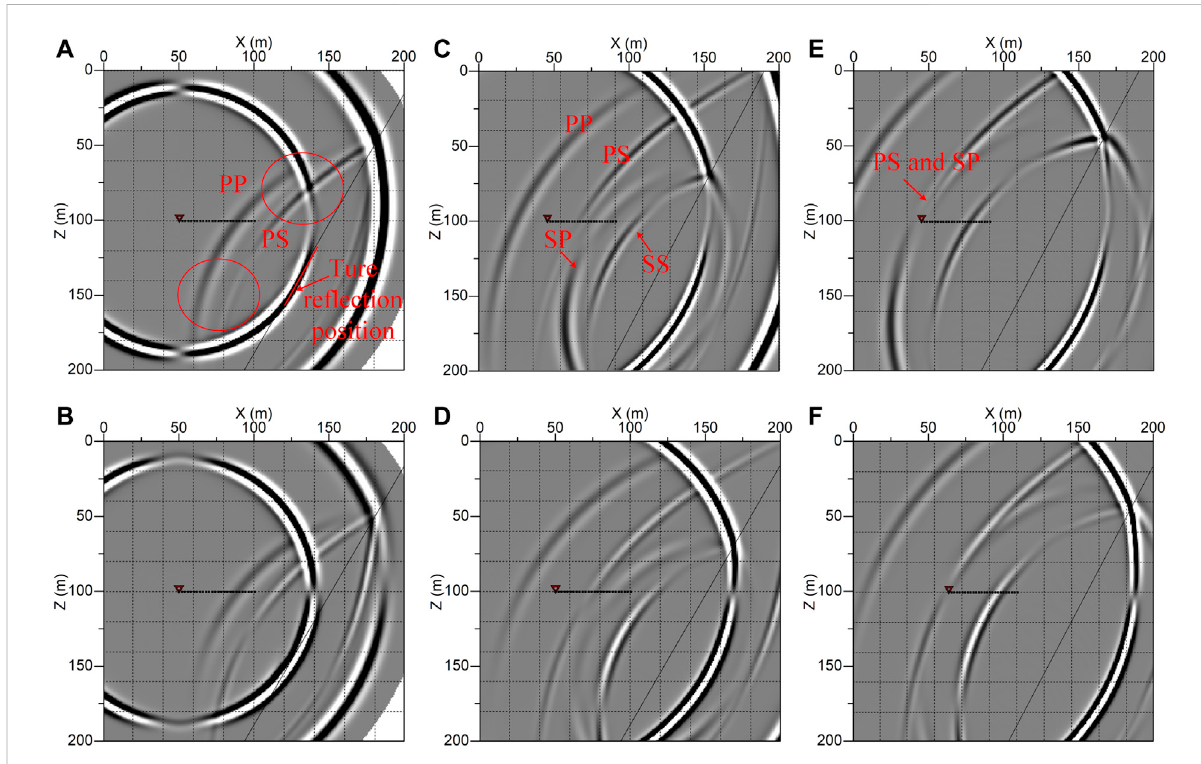
FIGURE 4 Snapshots of the rock roadway 60 ° dip fault model. (A) 40 ms X-component; (B) 40 ms Z-component; (C) 55 ms X-component; (D) 55 ms Z-component; (E) 65 ms X-component; (F) 65 ms